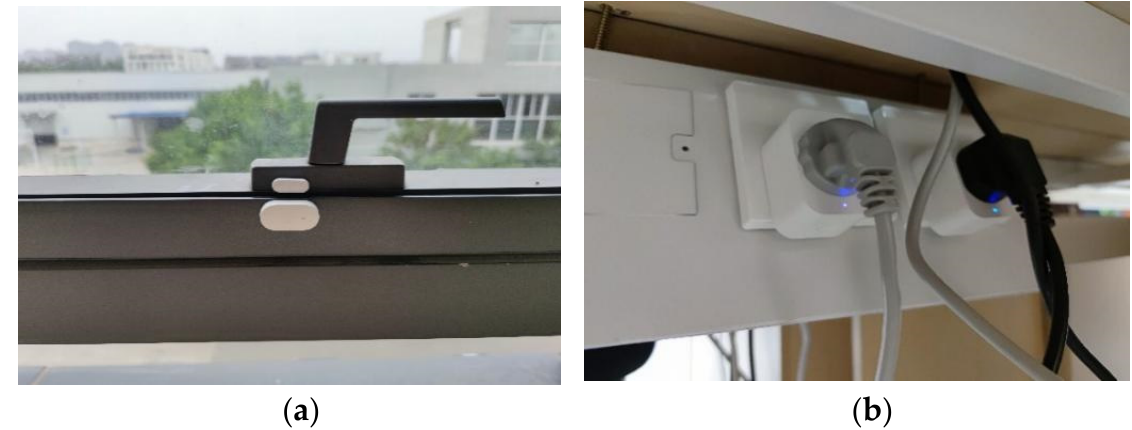
Figure 7. ( a ) Door and window sensors, ( b ) smart sockets.